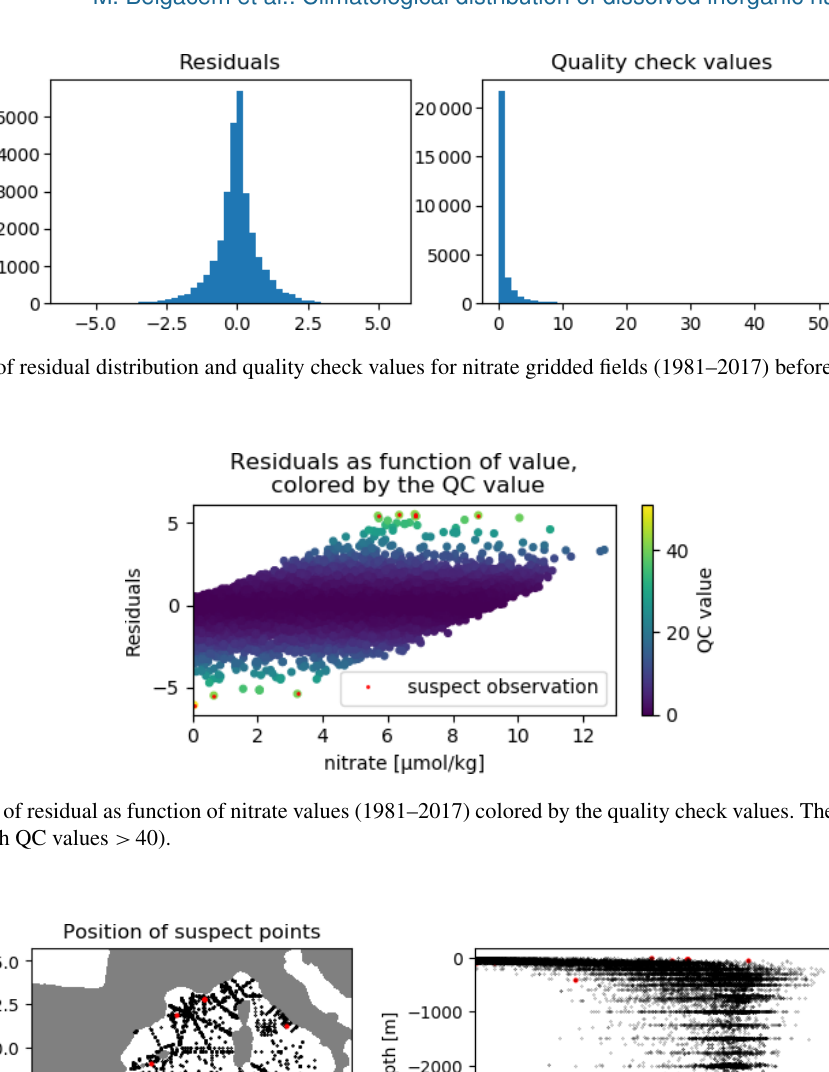
Earth Syst. Sci. Data, 13, 5915–5949,